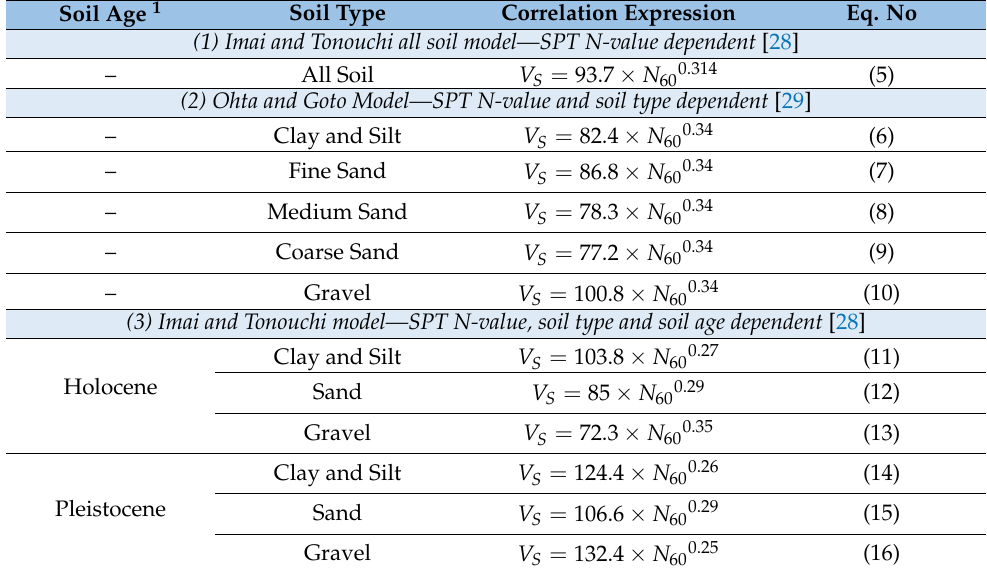
Table 1. Shear wave velocity and SPT N-value correlation